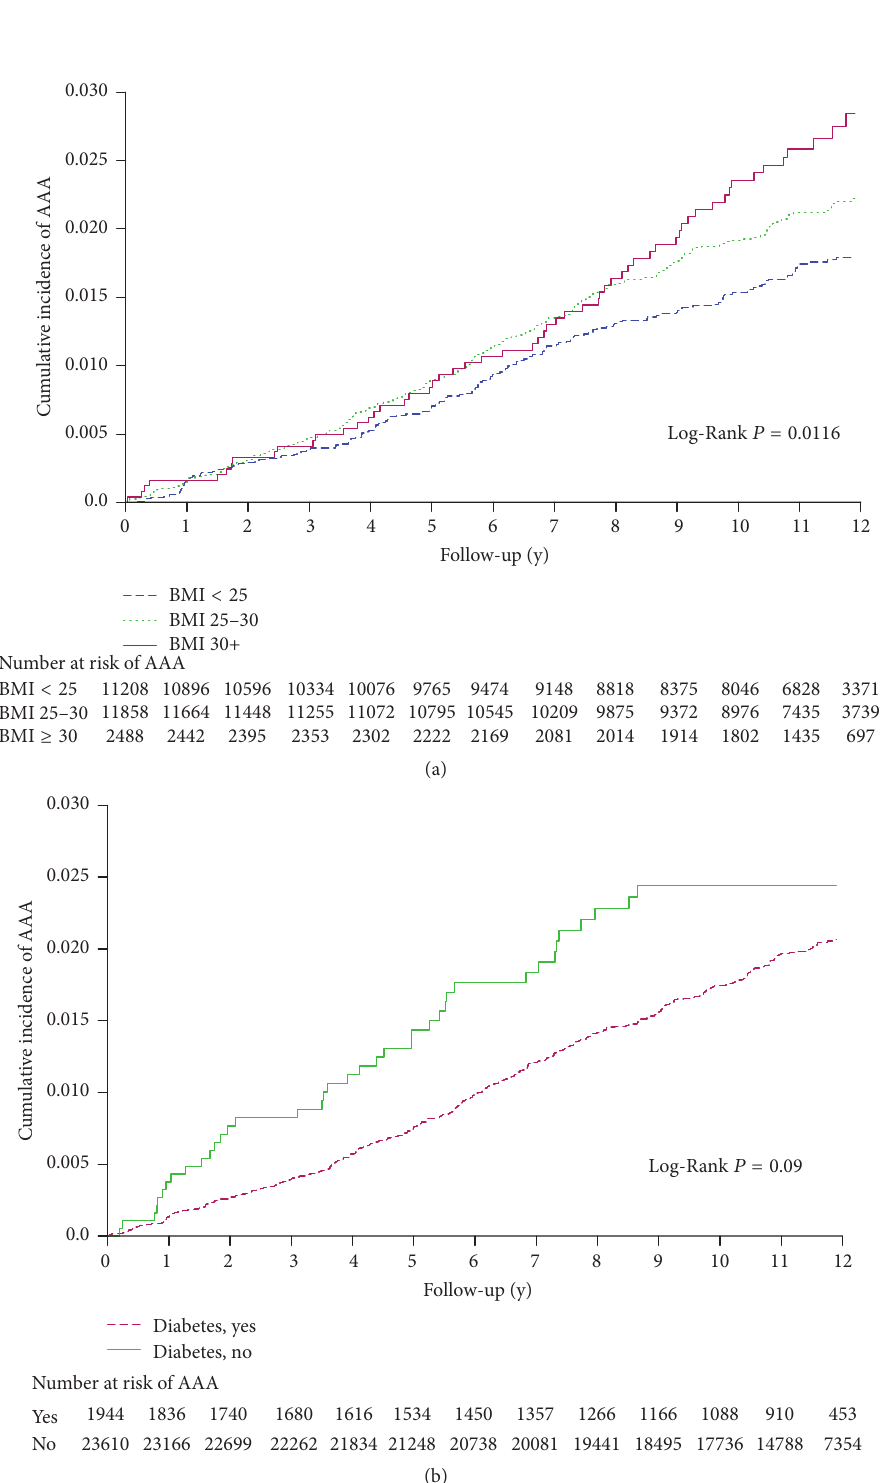
Figure 2: Cumulative incidence of clinically diagnosed AAA according to baseline BMI (a) and history of diabetes (b). Multivariable model adjusted for age, race, randomized treatment assignment, smoking status, alcohol use, vigorous exercise, history of cardiovascular disease, hypertension, and hypercholesterolemia. Model for BMI also adjusted for history of diabetes, and vice